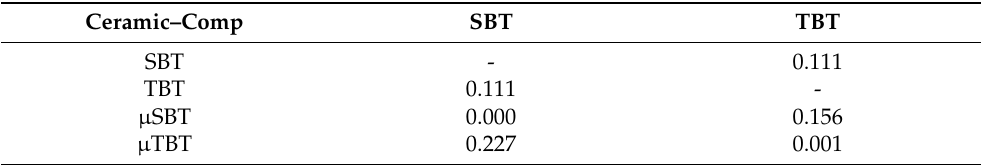
Table 5. Significant differences of bond strength values of ceramic to resin composite on the test method. For group descriptions see Figure 1.